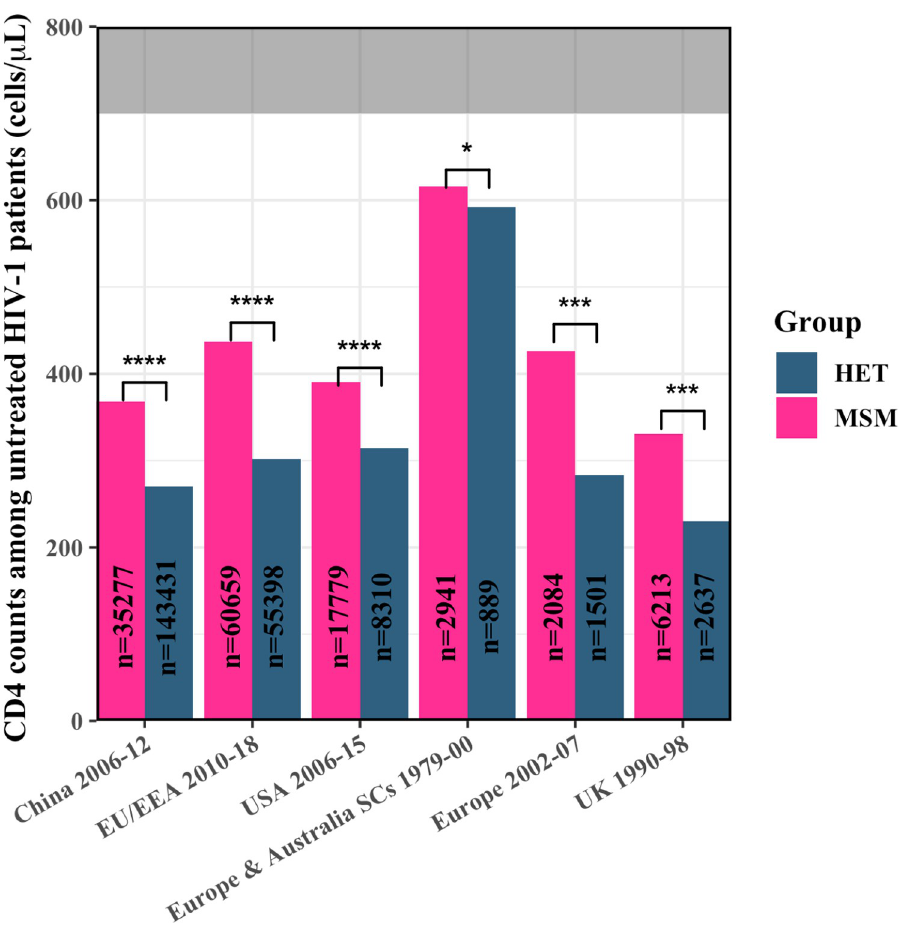
Fig 2. Early CD4 T cell counts in MSM and HET. Early mean CD4 cell counts in untreated infected adult HET and MSM from different geographical regions and calendar years (see Methods, Table 1 and S3–S5 Tables). The grey region indicates counts in uninfected, healthy individuals. The sample sizes ( n ) are shown. SCs are seroconverters. ���� , ��� , �� and � indicate P < 10 − 4 , P < 10 − 3 , P < 10 − 2 and P < 0.05, respectively. Table 1 and S3–S5 Tables). For instance, measurements from * 120,000 patients across 21 countries in the European Union and European Economic Area (EU/EEA) [27] indicated, fol- lowing population-weighted averaging of yearly data during 2010–2018, that the mean CD4 count in MSM at diagnosis was * 440 cells/ μ L, whereas it was substantially lower, * 300 cells/ = 0.54). The numbers were similar in the preceding 5 year μ L, in HET (P < 10 − 4 ; Cohen’s d , d s period (2002–2007) reported by a smaller study involving a few thousand patients [19]. In the UK [28], measurements from close to 9,000 patients during 1990–1998 showed that the counts at diagnosis were * 330 cells/ μ L in MSM and * 230 cells/ μ L in HET (P < 10 − 3 ; d = 0.41). In s China [31], during 2006–2012, the mean CD4 counts at diagnosis from * 180,000 patients were * 370 cells/ μ L in MSM and * 270 cells/ μ L in HET (P < 10 − 4 ; d = 0.39). Similarly, in the s US [30], from over 25,000 patients during 2006–2015, the counts at diagnosis were * 400 cells/ μ L in MSM and * 300 cells/ μ L in HET (P < 10 − 4 ; d = 0.30). We also examined the counts s at seroconversion where possible. Using the reported diagnosis delays and the slopes of CD4 count decline in the US population above [30], we estimated that the cell counts at seroconver- sion, for the age group 13–29 years, were * 550 cells/ μ L in MSM and * 480 cells/ μ L in HET